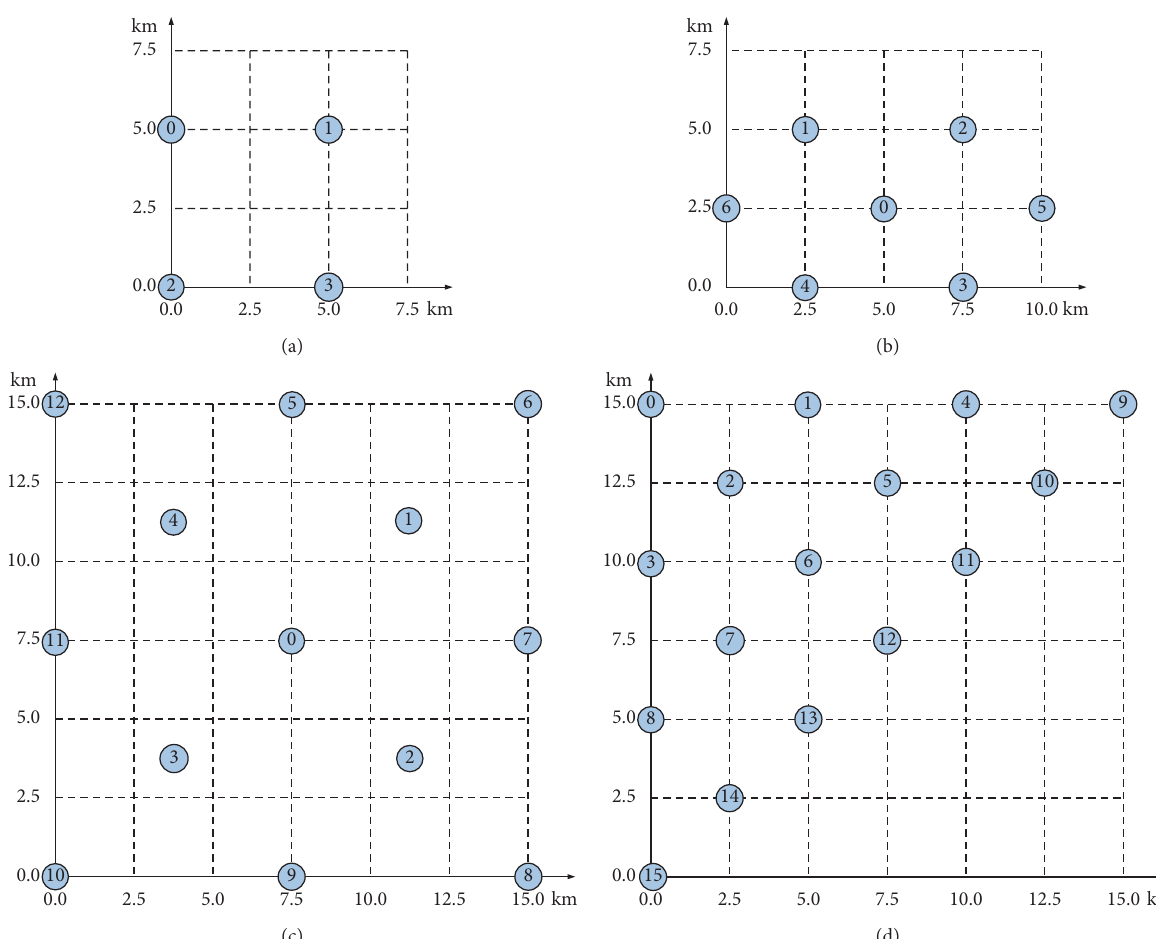
Figure 4: Simulation cases. (a) Case of 4 nodes. (b) Case of 7 nodes. (c) Case of 13 nodes. (d) Case of 16